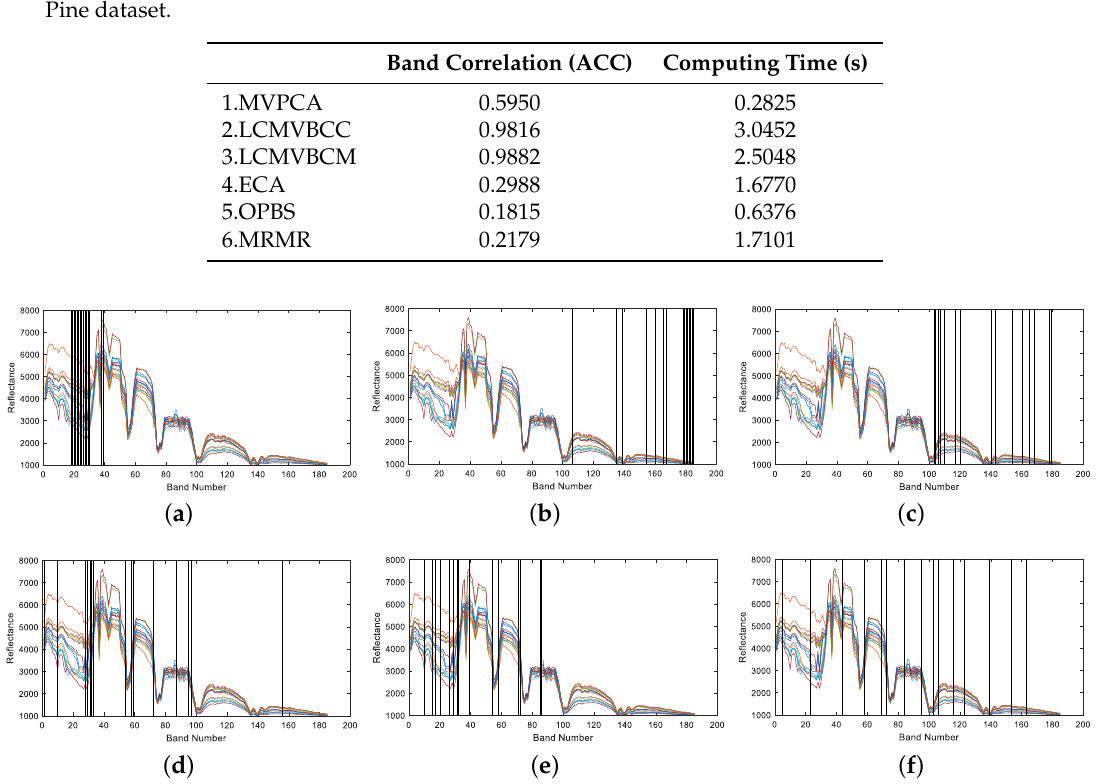
Figure 7. Spectrums of the categories on the Indian Pine dataset. The straight lines denote the bands selected by different BS methods. ( a ) MVPCA ( b ) LCMVBCC ( c ) LCMVBCM ( d ) ECA ( e ) OPBS ( f )